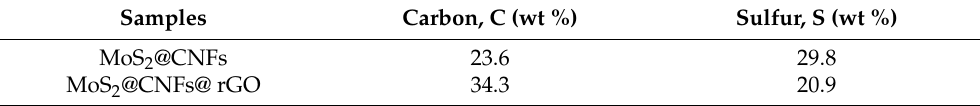
Table 1. Contents of the carbon and sulfur components of MoS 2 @CNFs and MoS 2 @CNFs@rGO.